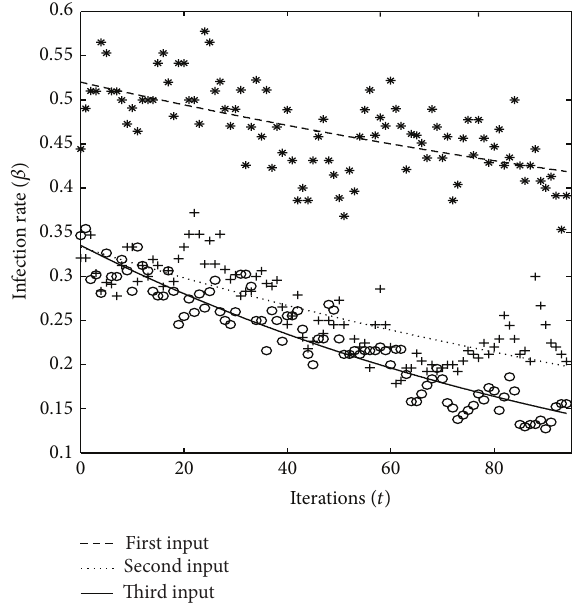
Figure 4: Adjusted CD4 + T lymphocyte infection rates in function of time for the three